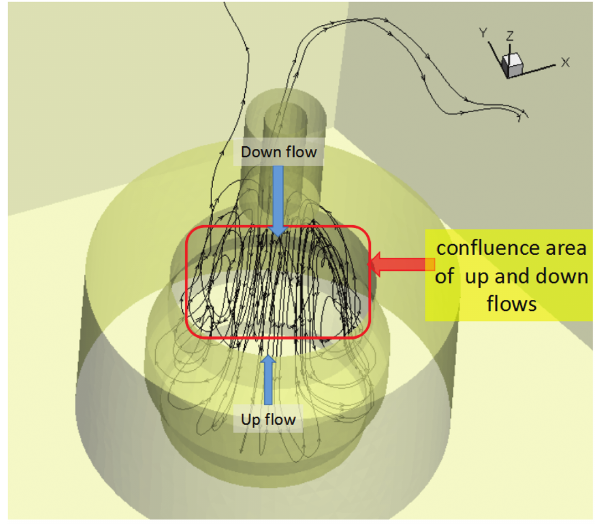
Figure 4: The stream line diagram of flow field in impact zone of tundish with traditional